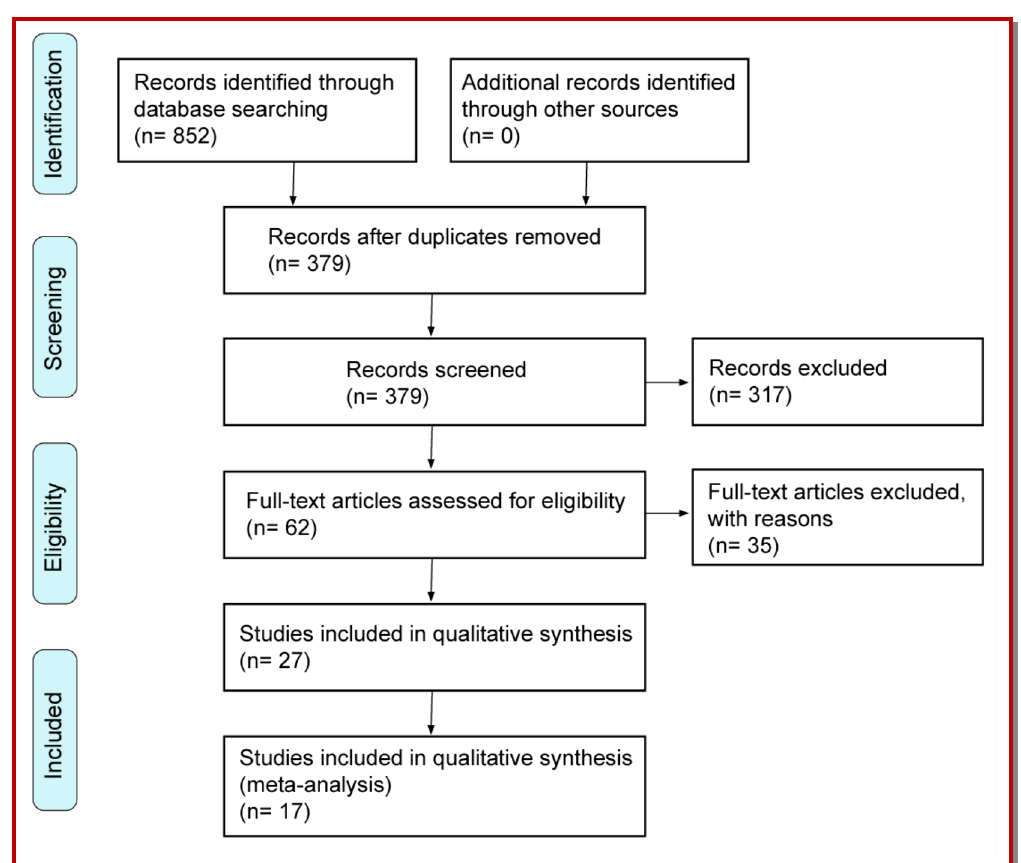
Figure 1: Flow diagram of included